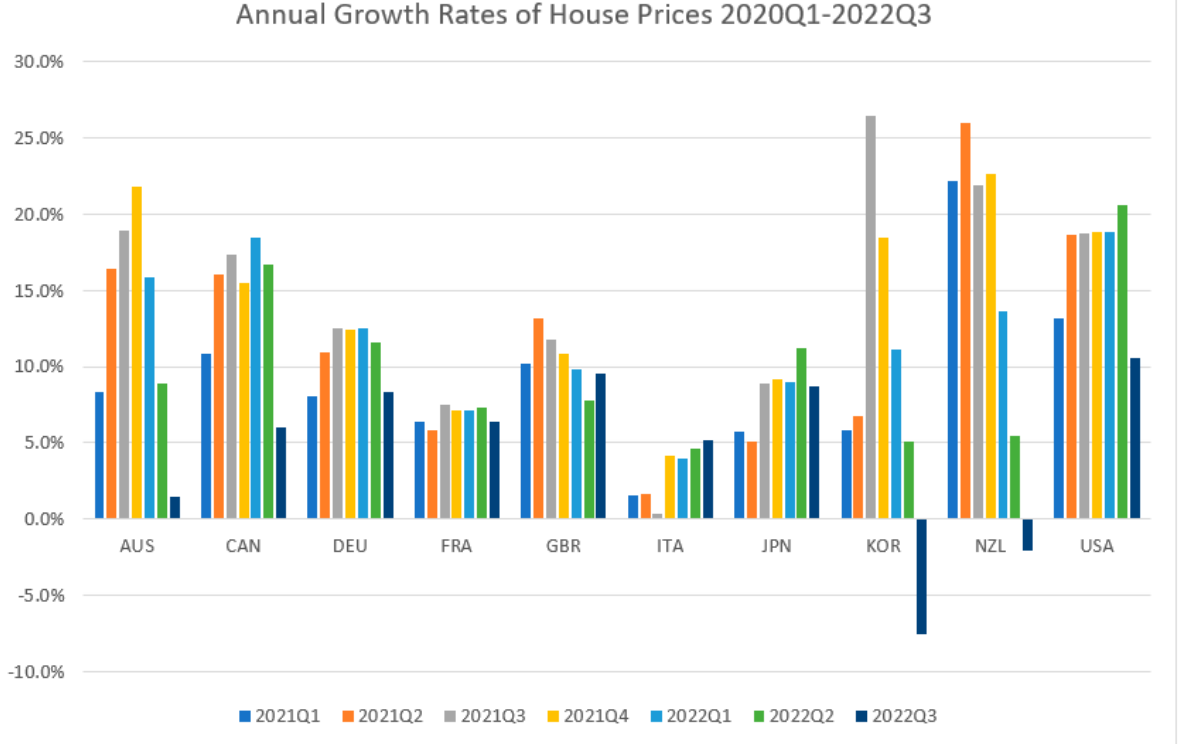
Figure 2. Annual growth rates of house prices of ten countries from 2020 Q1 to 2022 Q3. Source: data from Knight Frank (2021–2022) [42]. Legend: Australia (AUS), Canada (CAN), Germany (DEU), France (FRA), Great Britain (GBR), Italy (ITA), Japan (JAP), South Korea (KOR), New Zealand (NZL), and the United States of America (USA).